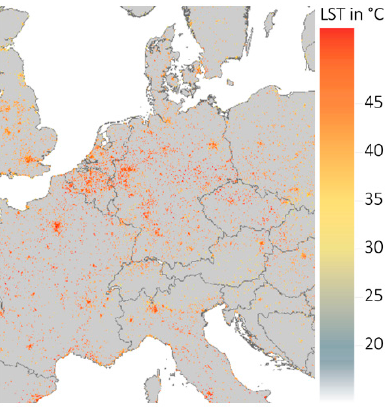
Figure 9. LST in built-up areas.